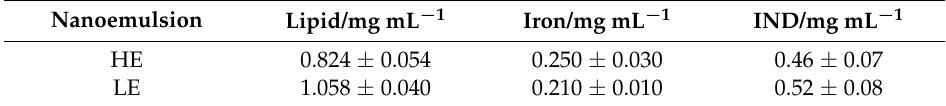
Table 1. Content in lipid, iron, and IND of the nanoemulsions (NE) obtained by high energy (HE) and low energy (LE) methods. The lipid is referred to the phospholipid content of the nanoemulsion. Values are the average ± standard deviation ( n = 3).